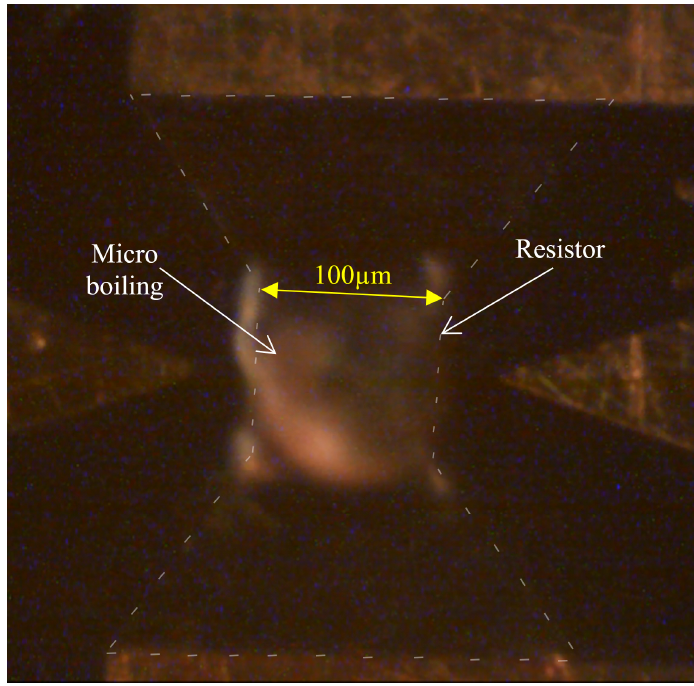
Figure 6. Micro-boiling process.